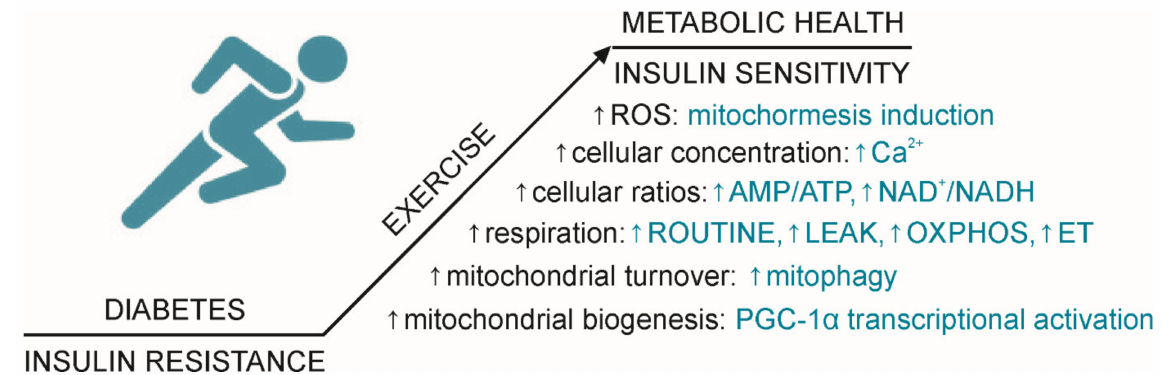
Figure 1. Cellular mechanisms underlying exercise as lifestyle intervention in T2D. Exercise increases insulin sensitivity in T2D by affecting energy metabolism through induction of mitochormesis, stimulation of mitochondrial turnover and biogenesis, increase in Ca 2+ concentration, AMP/ATP and NAD + /NADH ratios and increase in respiration: ROUTINE, LEAK, OXPHOS and ET capacity. Symbol: ↑ =